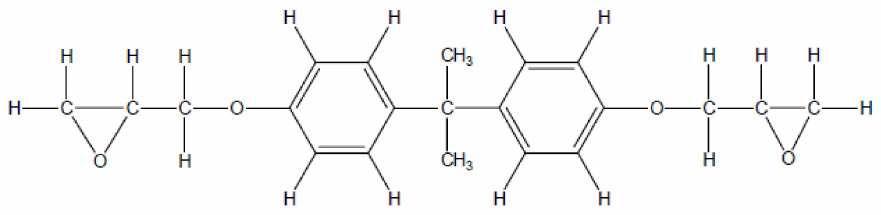
Figure 8. Chemical structure of bisphenol-A epoxy resin